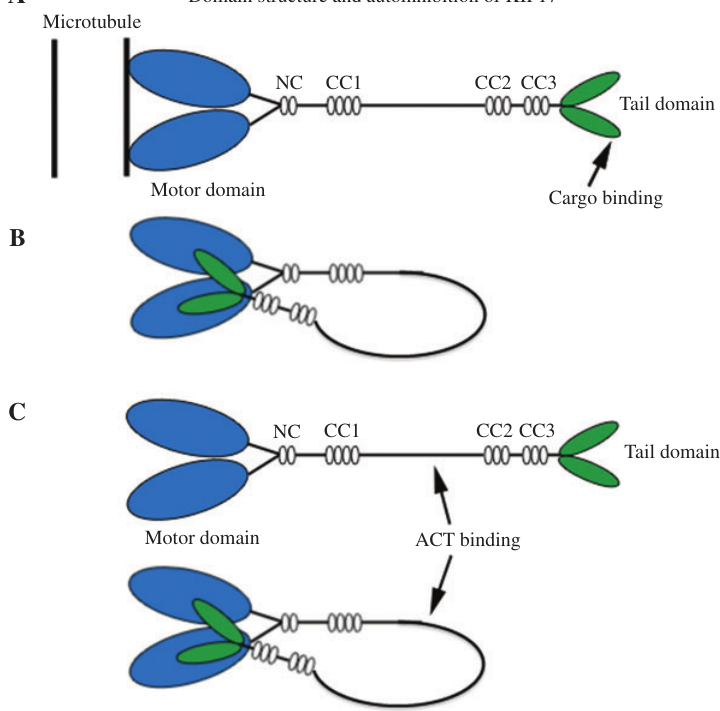
Figure 2 Diagrammatic representation of the KIF17 homodimer in its active (A) and auto-inhibited (B) confi gurations. In panel (B), the cargo binding tail domain (green) associates with the microtubule binding ATPase head domain (blue). Cargo binding could involve intermediate adaptor complexes, as in the case of NR2B traffi cking in dendrites or IFT traffi cking in cilia. However, in the testis, ACT binds to an intermediate domain (C) within the stalk rather than the tail in a regulatory event that occurs independently of KIF17 motor activ- ity and microtubules. The structural confi guration of KIF17 for ACT binding is not known, but in theory could occur in either the extended or auto-inhibited confi guration. Not drawn to scale. CC, coiled-coil domains 1, 2, and 3; NC, neck coil